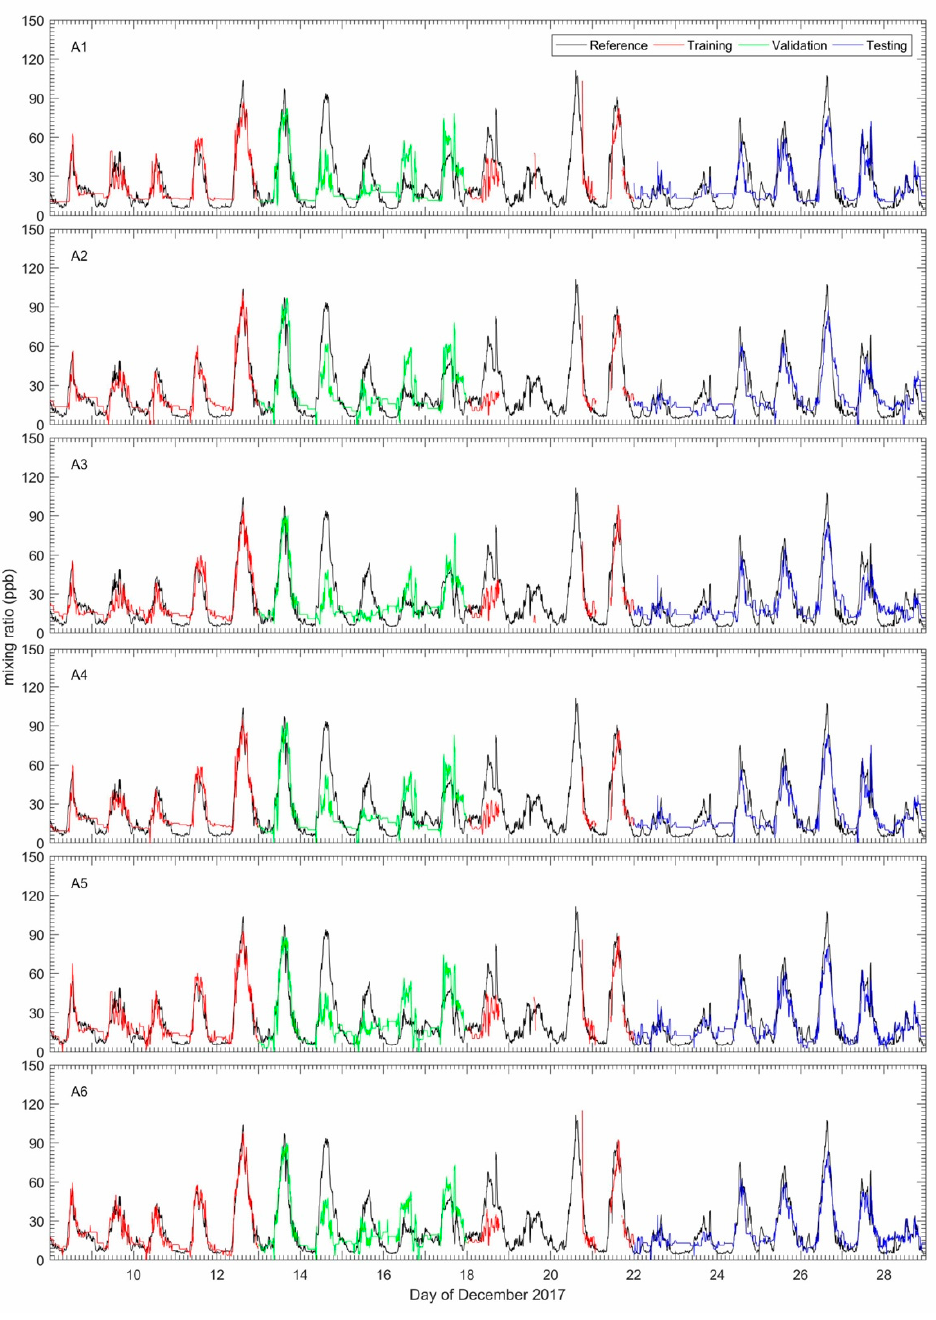
Figure 11. Variation of O 3 measured from ANFIS calibration model compared with reference instrument for whole combination input.